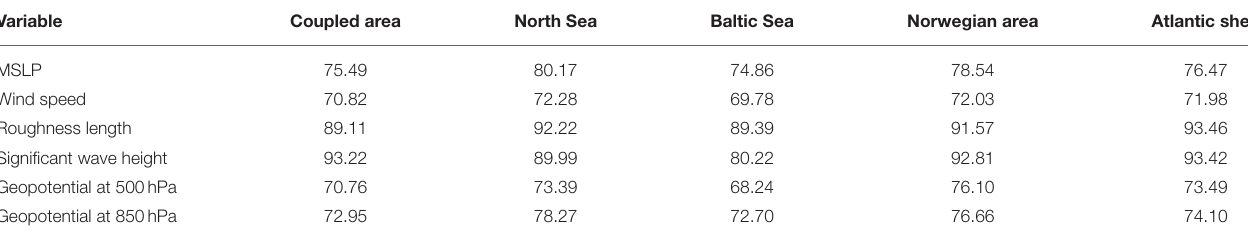
TABLE 2 | Time with significant differences between the coupled (cpl.nsn) and reference (ref.nsn) ensembles